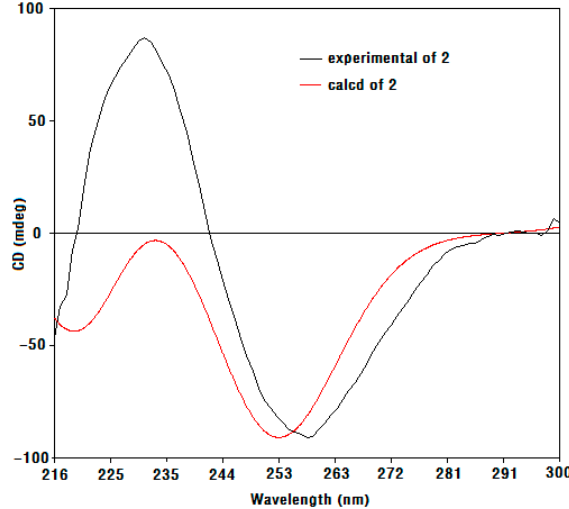
Figure 5. Calculated and experimental CD spectra of compound 2 .